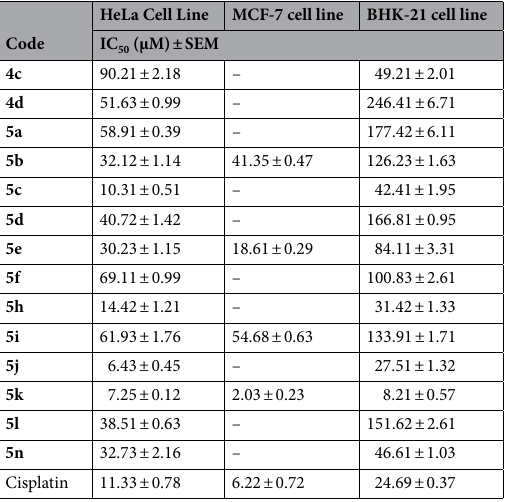
Table 2. IC 50 values of the most active pyrazolo-pyridine ( 4a–4n ) and pyrazolo-naphthyridine ( 5a–5n ) derivatives. SEM standard error of mean.